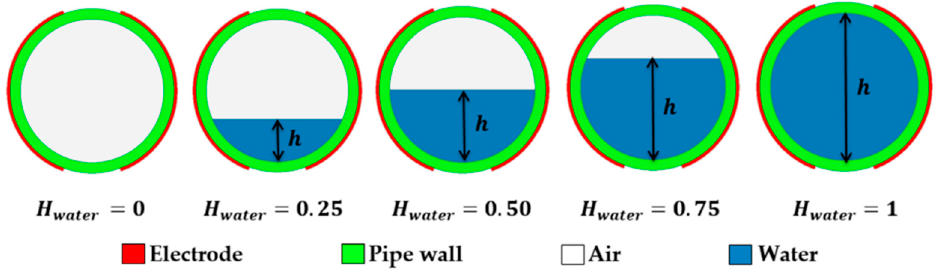
Figure 2. 2D view of different holdup values for air-water smooth stratified flow.